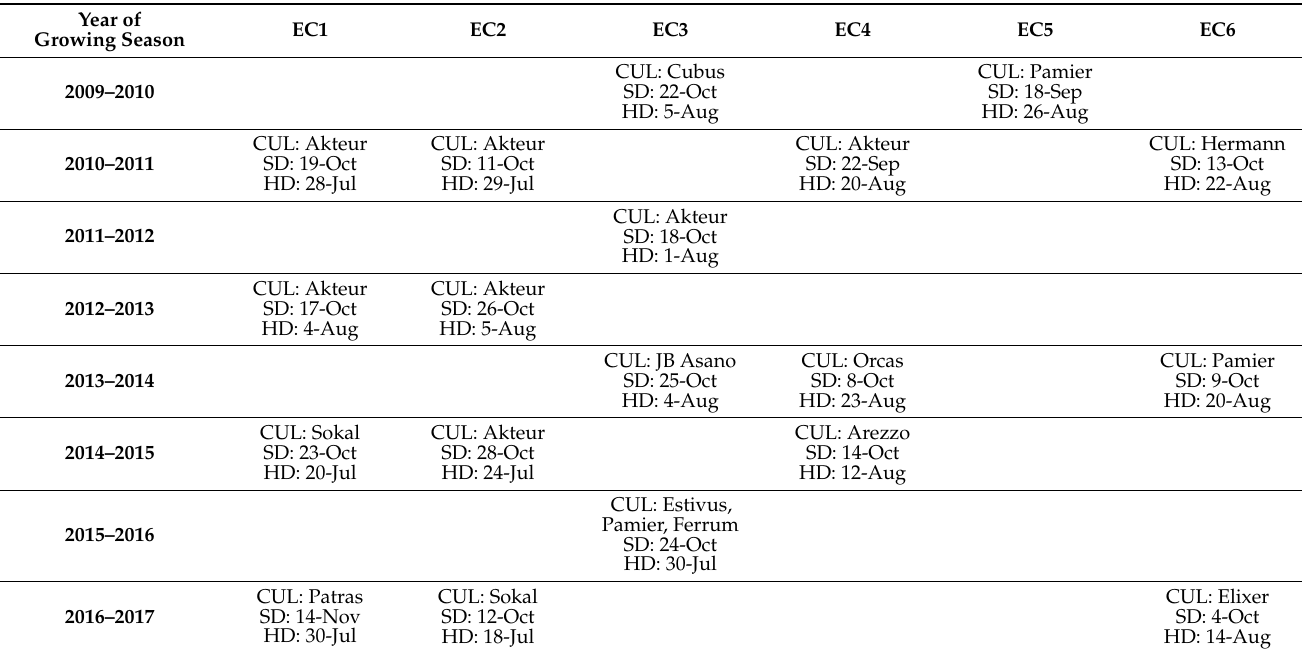
Table 1. Information on winter wheat ( Triticum aestivum ) cultivars (CUL), sowing dates (SD) and harvest dates (HD) for the studied site-years. The empty cells denote periods when other crops were grown.